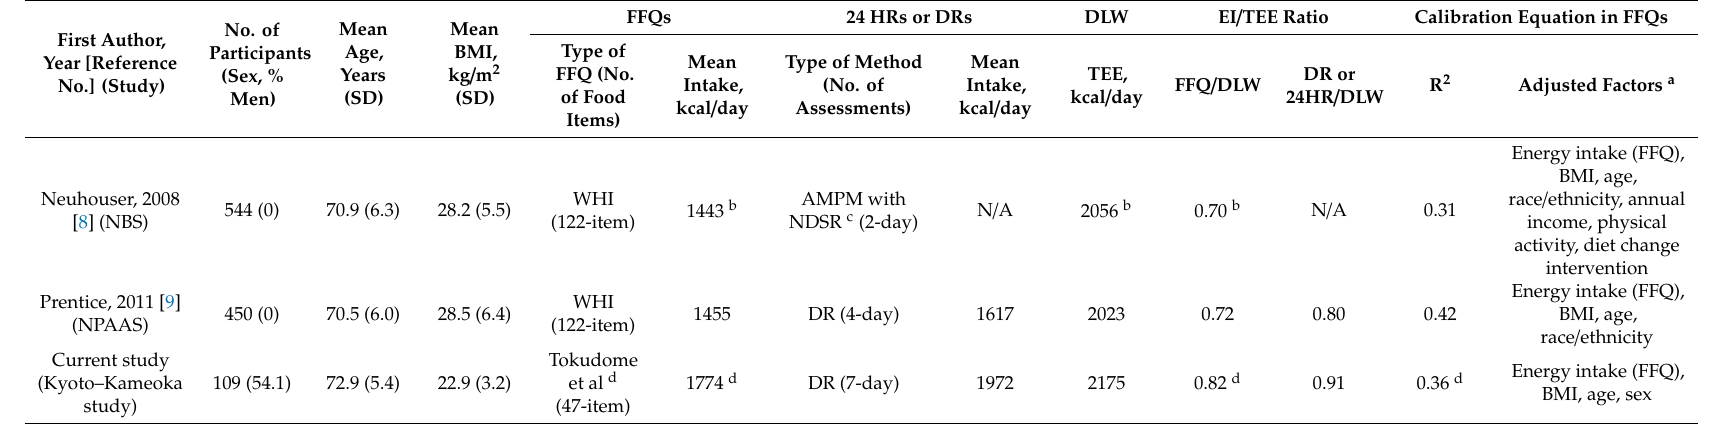
Table 5. Review of previous and current studies on the developed calibration equation for energy intake from a self-reported dietary assessment and doubly labeled